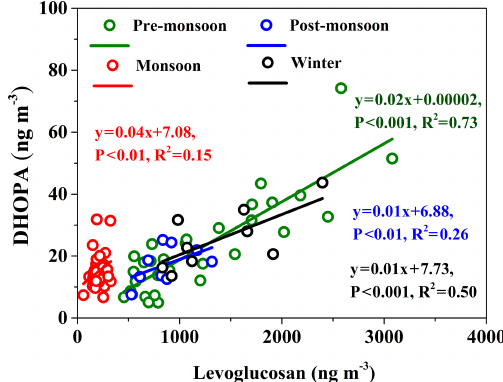
Figure 9. Correlation between 2,3-dihydroxy-4-oxopentanoic acid (DHOPA) and levoglucosan in Bode aerosols during the sampling period (April 2013–April